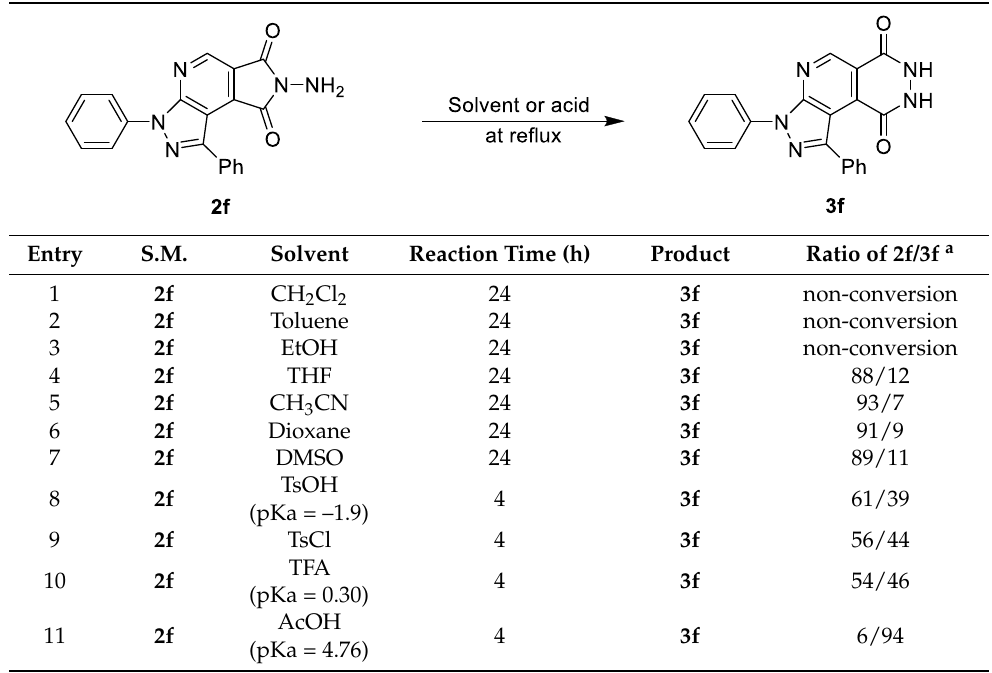
Table 3. Derivatization results of N -aminophthalimides 2a–e and phthalazine 1,4-diones 3a–e with Vilsmeier reagent.